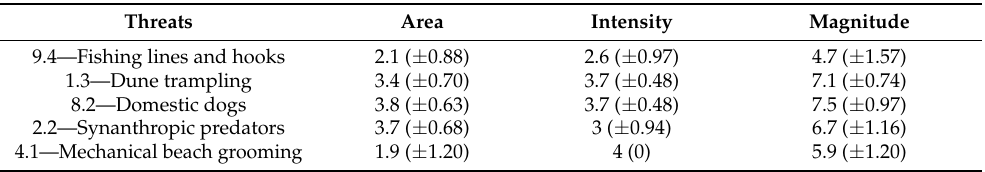
Table 1. Threat Analysis (TAN) procedure. Mean values (and ± standard deviation) in regime attributes (area, intensity, and magnitude) for the human-induced direct threats selected in the ‘Torre Flavia’ Special Protection